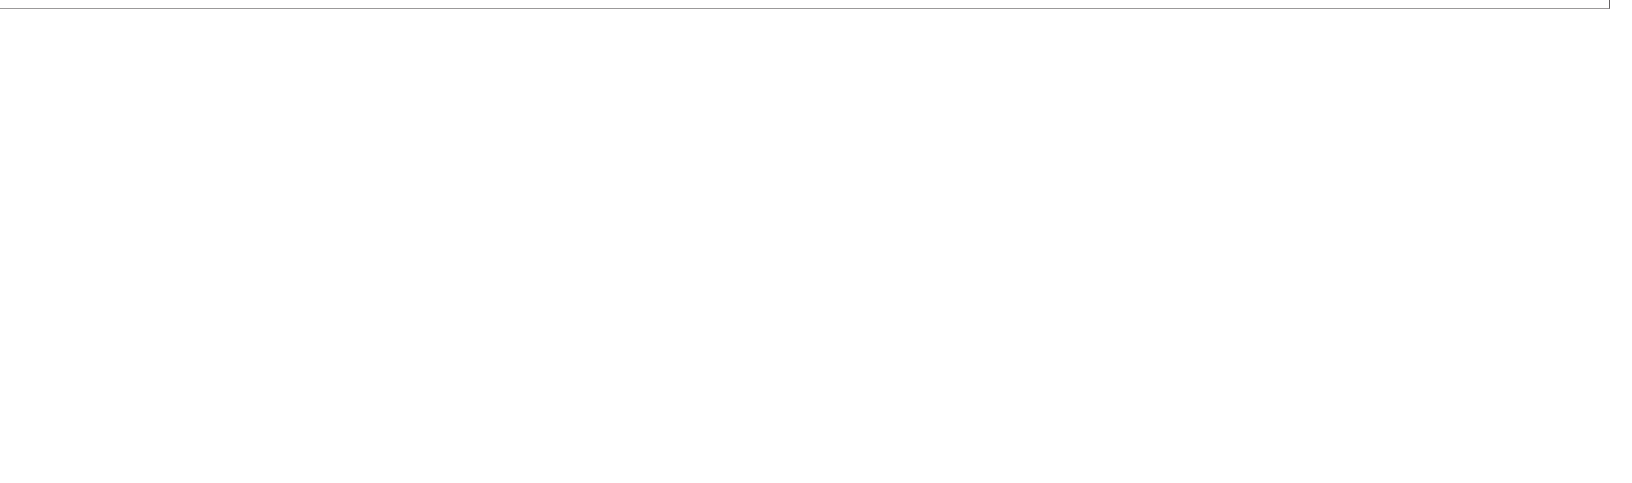
FIGURE 2 | Con fi rmation of phylloquinone by high resolution mass spectrometry (LC-QToF / system III). Three different extracts were analyzed. Infected erythrocytes (A) ; phylloquinone standard (B) ; uninfected erythrocytes (C) . The signal obtained at 20.3 min of all fractions were compared with their mass